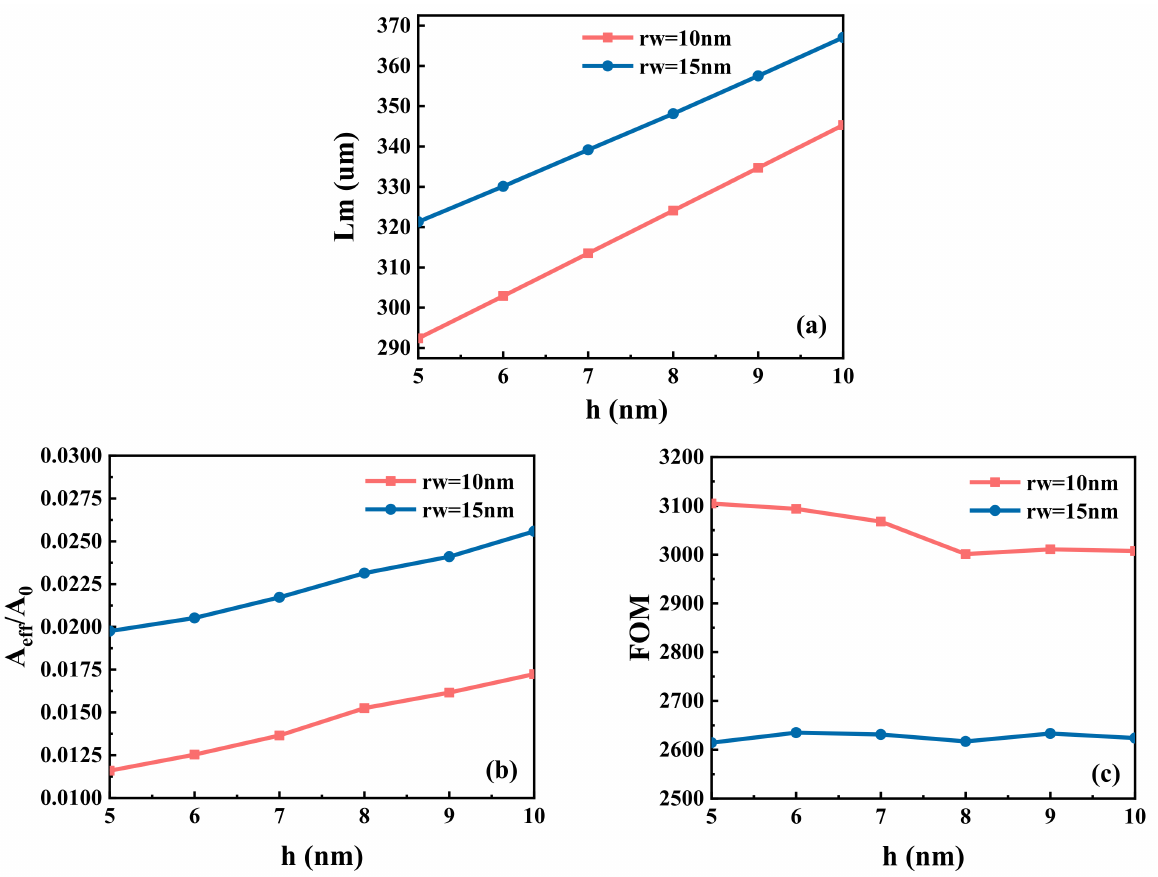
Figure 3. Dependence of modal properties on the height of silicon dioxide gap h for different curvature radius rw : ( a ) propagation length L m ; ( b ) normalized effective mode area A ef f / A 0 ; and ( c ) figure of merit FOM